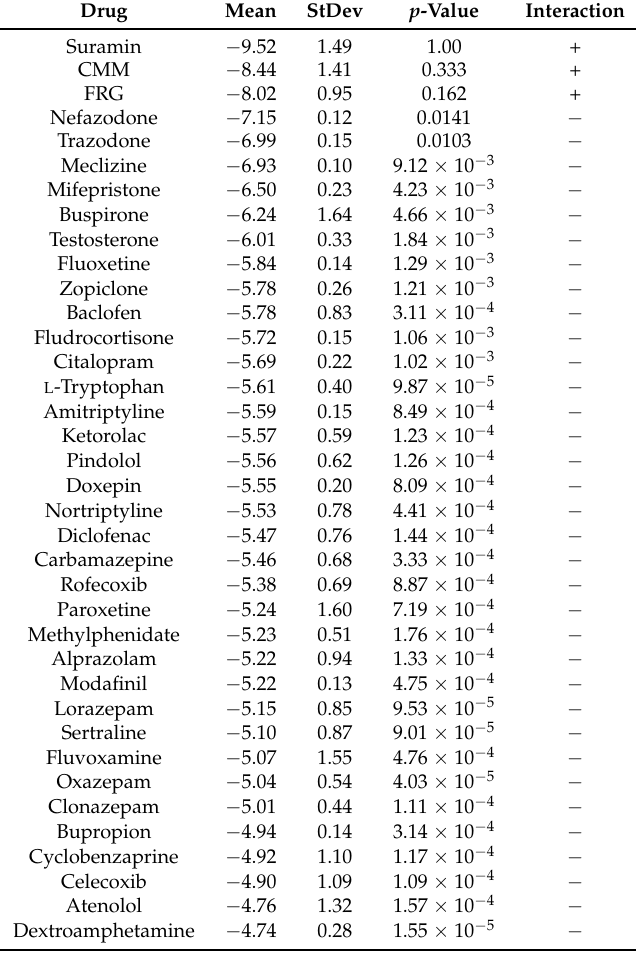
Table 7. Interaction between common drugs used to treat GWI symptoms and IL-2. Mean binding energy and standard deviation are in units of kcal/mol. A t -test used to compare with the known binder suramin. (+) indicates putative binding, ( − ) indicates no putative